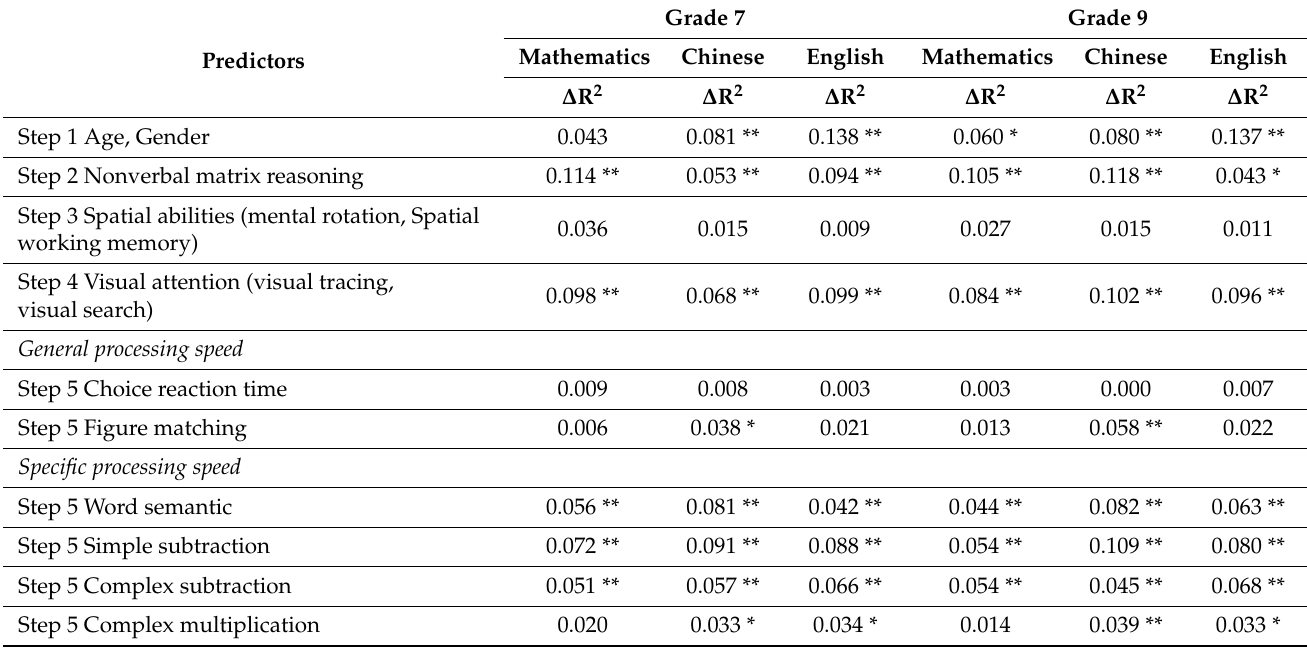
Table 2. Hierarchical regression models predicting academic achievement in Grades 7 and 9 of junior high school considering age, gender, cognitive tests, and general and specific processing speed. Grade 7 Grade 9 Predictors